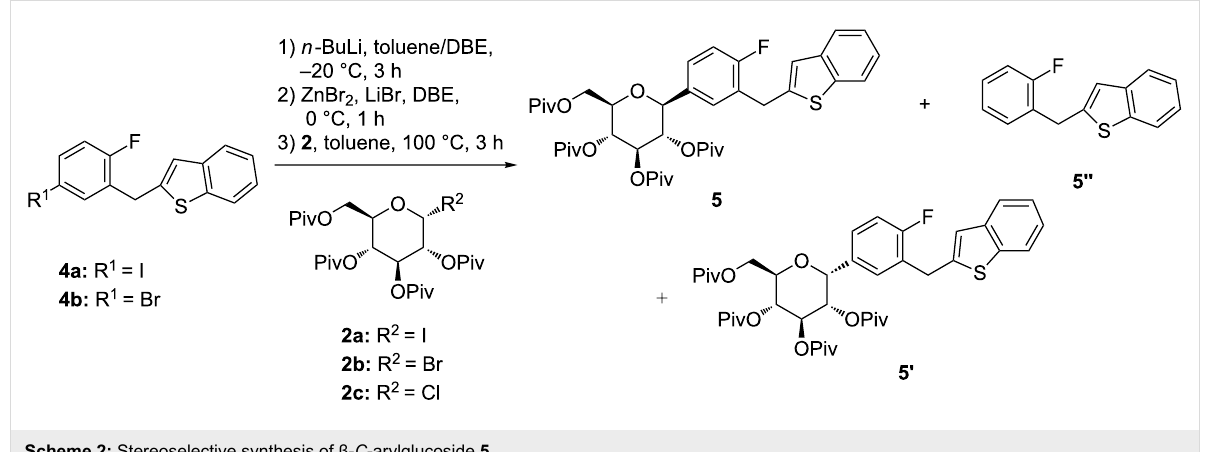
Scheme 2: Stereoselective synthesis of β - C -arylglucoside 5 .